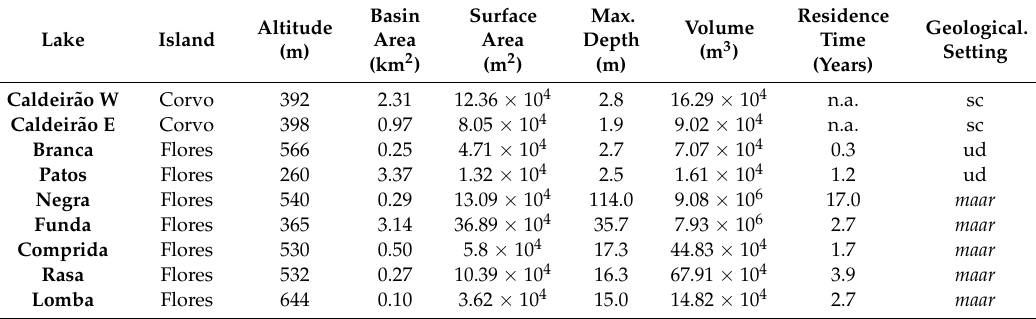
Table 1. Characterization of the studied lakes on Corvo and Flores islands (residence time from Azevedo (1998) and AHA-DRA (2015) [45,46]; altitude, basin area, surface area, maximum depth, and water storage volume from the present study; geological setting according to Cruz et al. [47]: sc—subsidence caldera, ud—undifferentiated depression, and n.a.—not